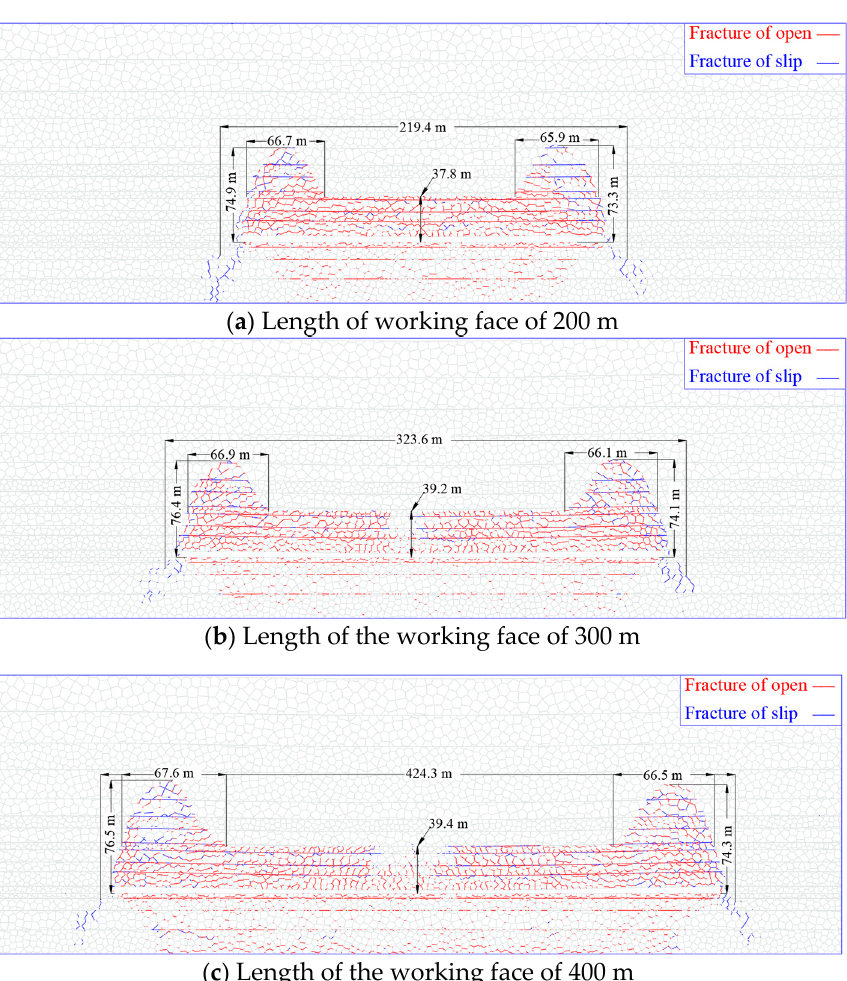
Figure 10. Development heights of the fracture zone under different lengths of the working face. Overlying strata are provided with activity space after the stoping of the working face. There are caving, fracture, and curved subsidence zones in the stope from bottom to top. The fracture developments are different in different regions of the fracture zone. after rotary sinking. Fractures in this region are highly developed. Overlying strata in the middle of the working face subside as a whole. Some opened fractures are developed for re-compaction. The height of the fracture is small after stabilization, which presents a saddle-shaped development. Table 1 shows the fracture development in different regions. Table 1. Fracture development at different lengths of the working face.